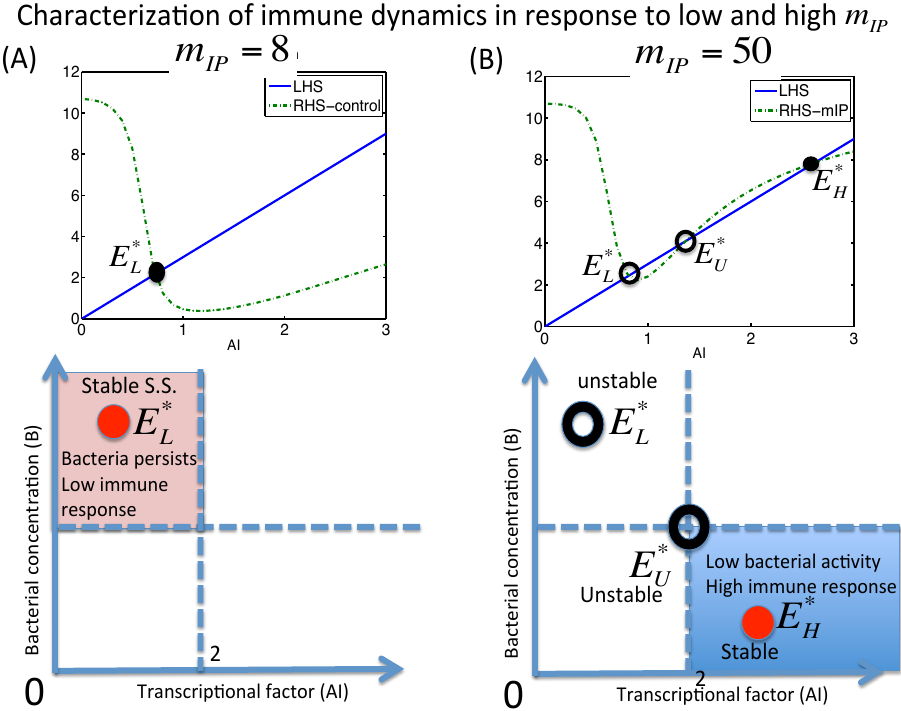
Figure 3. Characterization of the protease activation and immune response in the M1 model. Circles in the lower panels represent the steady state solutions of (11) for high and low values of a control parameter m IP , the activation rate of proteases from the transcription factor in the cell. The intersection (black circles) of the straight line (left-hand side of (11); blue solid line) and curve (right-hand side of (11); green dotted curve) corresponds to the numerical value of A ∗ in the upper panel. * Black I filled circle = stable, empty circle = unstable. ( A ) The bacterial persistence phenotype in response to the weak activation of proteases ( m IP = 8.0). There exists a unique positive stable equilibrium E ∗ L in the region (pink box) where transcription factor activities are reduced and bacterial persistence is observed. ( B ) Suppression of bacterial growth by immune activities in response to enhanced activation of proteases ( m IP = 50). There exist three positive equilibria E ∗ , E ∗ and E ∗ simultaneously. While L U H two equilibria E ∗ and E ∗ are unstable, the equilibrium E ∗ is stable. The equilibrium E ∗ resides in the L U H H region (blue box) where bacterial activities are reduced and high internal immune responses persist. All other parameters are fixed as in Table